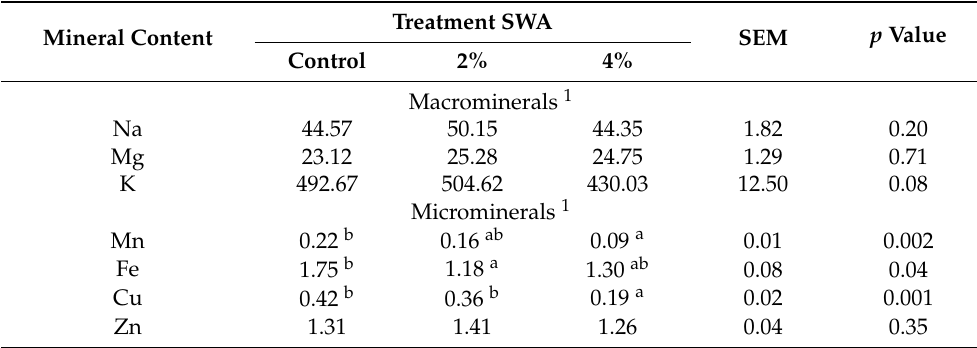
Table 4. Effects of the inclusion of seaweed additive (SWA) in the diet of fattening pigs on the mineral content in pork meat.